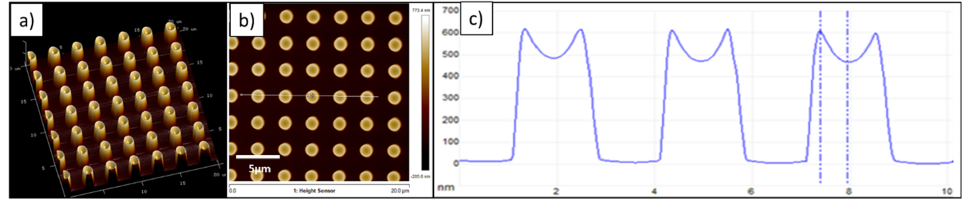
Figure 8. AFM images showing incomplete filling behavior of pillars with 1 µm diameter and 1.3 µm height. ( a ) Tilted view, ( b ) top view, and ( c ) height profile. In the top view, the line scan for the height profile can be seen.